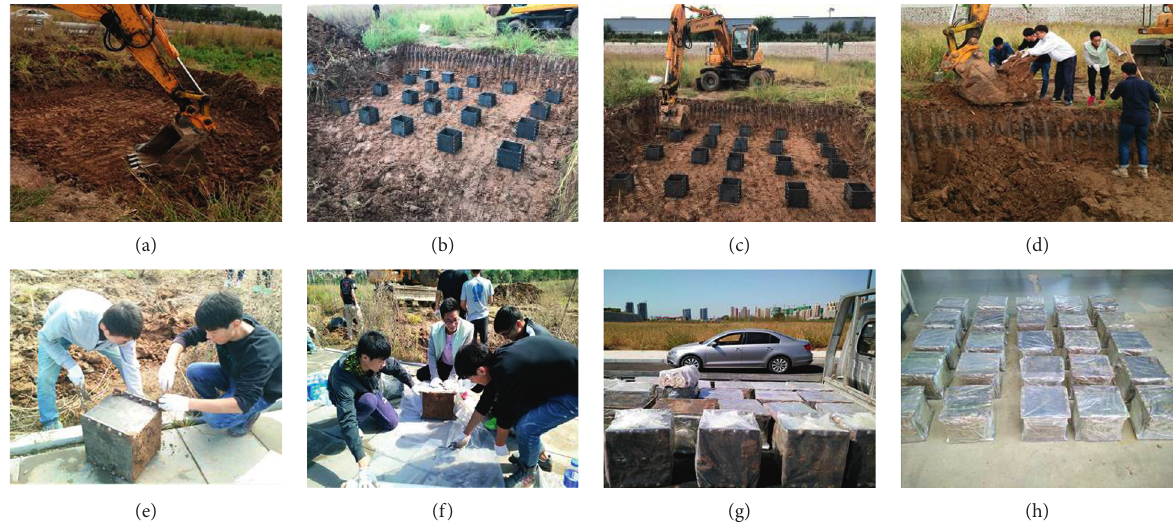
Figure 8: Collecting undisturbed soil at the site and making arrangements. (a) Leveling of soil collection. (b) Placing soil collector. (c) Pressing soil collector in soil. (d) Digging out soil collector. (e) Cleaning soil collector. (f) Packaging soil collector with plastic film. (g) Transporting soil collector. (h) Saving test specimens.